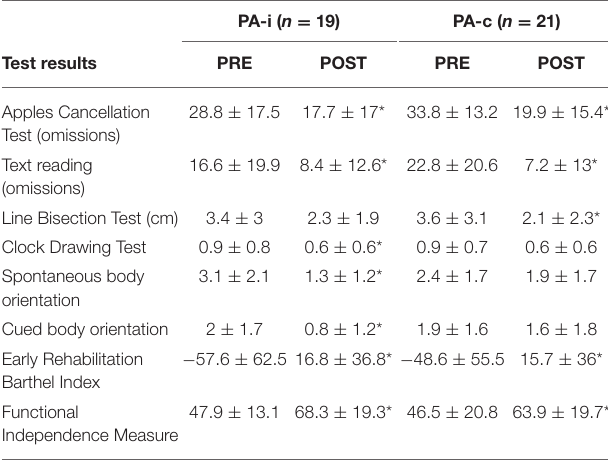
TABLE 2 | Test results of the two combined PA groups (both series and after completing both conditions of cross-over design) following an intermittent or continuous